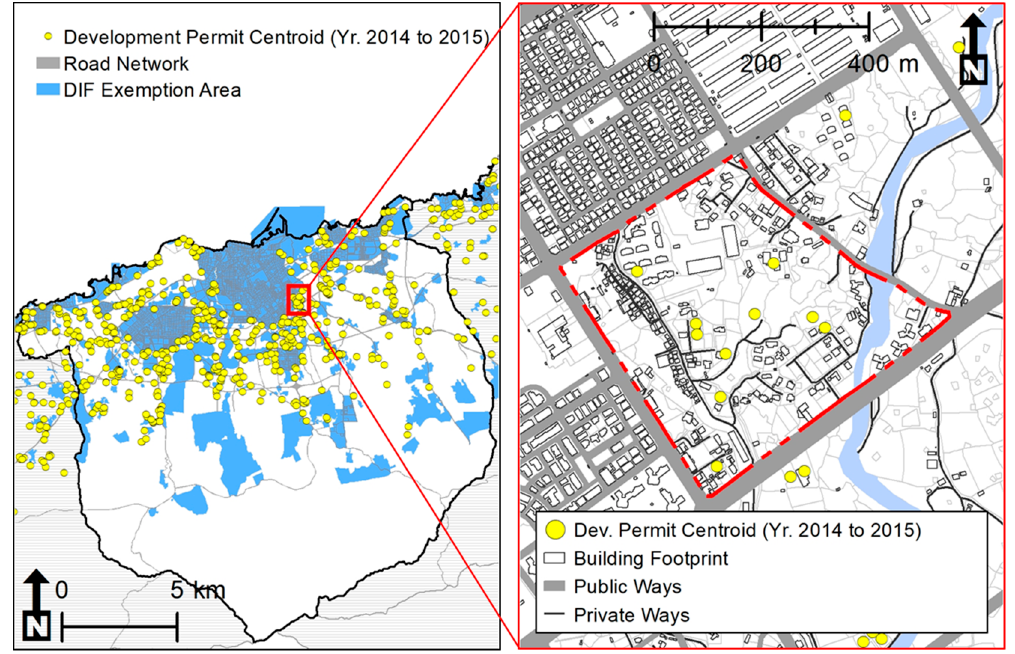
Figure 3. Location of the site for the virtual development project.